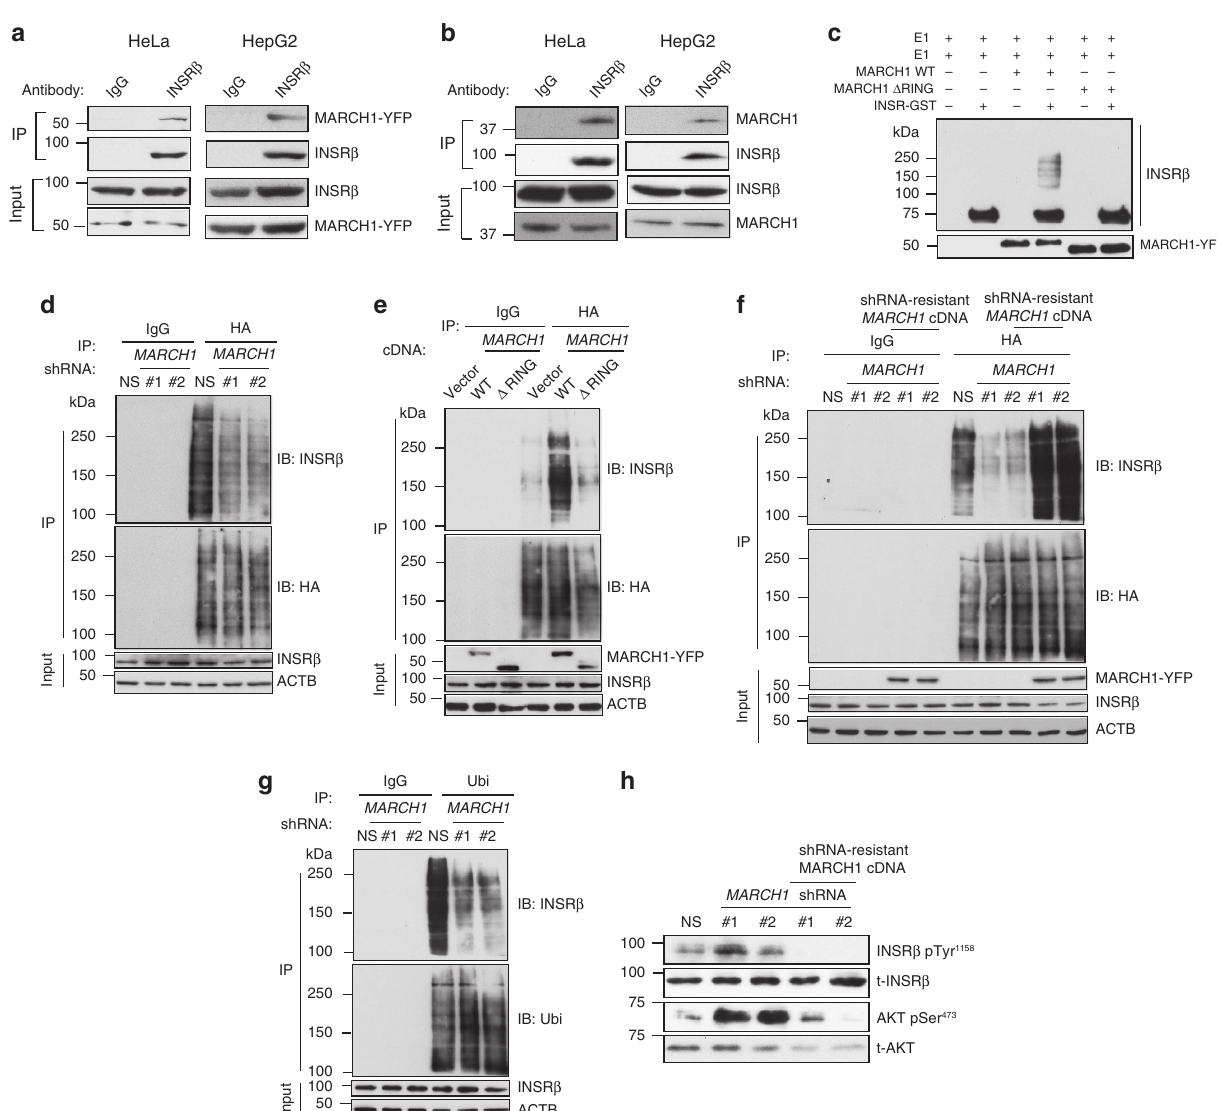
Figure 8 | MARCH1 interacts with INSR and regulates its half-life by ubiquitination. ( a ) Co-immunoprecipitation of INSR b and MARCH1 from HeLa and HepG2 cells expressing MARCH1 - YFP . ( b ) Co-immunoprecipitation of INSR b and endogenous MARCH1 from HeLa and HepG2 cells treated with the proteasome inhibitor MG132. ( c ) In vitro ubiquitination assay. Input was analysed for MARCH1 expression. ( d ) Immunoblot analysis of INSR b ubiquitination. HA-ubiquitinated proteins immunoprecipitated from HeLa cells expressing NS or MARCH1 shRNAs and HA-ubiquitin were immunoblotted for INSR b and for HA-ubiquitin. Lysates were probed for the indicated proteins. ( e ) Immunoblot analysis of INSR b polyubiquitination. HA-ubiquitinated proteins immunoprecipitated from HeLa cells expressing MARCH1-YFP or MARCH1- D RING-YFP and HA-ubiquitin were immunoblotted for INSR b and for HA-ubiquitin. Lysates were probed for indicated proteins. ( f ) Immunoblot analysis of INSR b polyubiquitination. HA-ubiquitinated proteins immunoprecipitated from HeLa cells expressing NS or MARCH1 shRNA #1 or #2 with or without shRNA-resistant MARCH1 cDNA were immunoblotted for INSR b and HA-ubiquitin. Lysates were probed for indicated proteins. ( g ) Immunoblot analysis of INSR b ubiquitination. Ubiqitinated proteins immunoprecipitated from HeLa cells expressing NS or MARCH1 shRNAs were immunoblotted for INSR b and for Ubiquitin. Lysates were probed for the indicated proteins. ( h ) Immunoblot analysis of insulin-stimulated INSR and AKTactivation in HeLa cells. HeLa cells expressing NS or MARCH1 shRNAs with or without shRNA-resistant MARCH1 cDNA were analysed for indicated